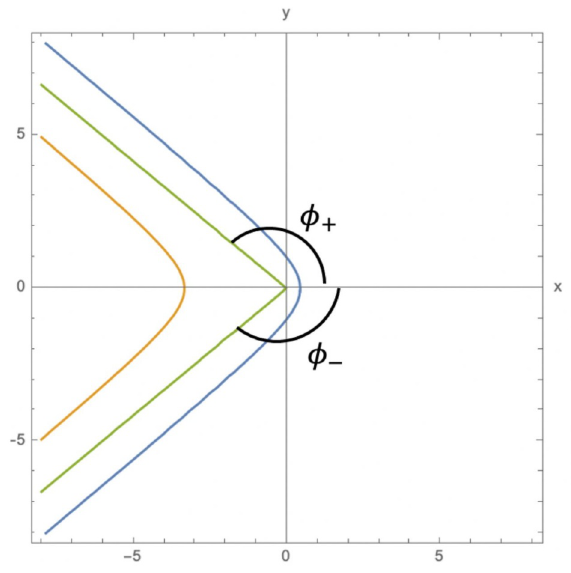
Figure 8 . Here we plot two conic sections for e = 1 . 3 with α = +1 (blue) and α = − 1 (orange). The lines defining the angles φ are also plotted in ±